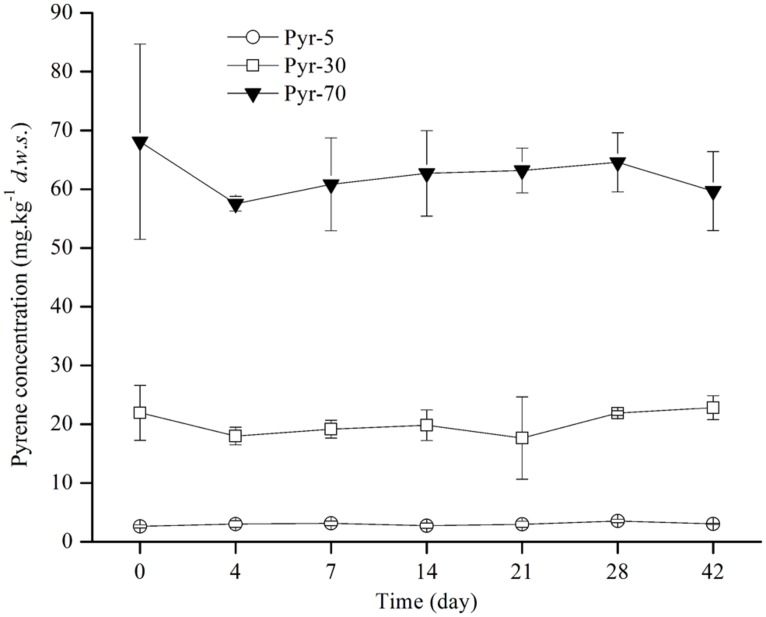
Pyrene concentration dynamics in soil during the incubation period. The designations Pyr-5, Pyr-30, and Pyr-70 indicate that the soil was treated with different concentrations of pyrene representing 5, 30, and 70 mg ⋅ kg-1
d.w.s., respectively. The designation d.w.s. refers to dry weight soil. The error bars represent the standard deviation of the means of triplicate microcosms.